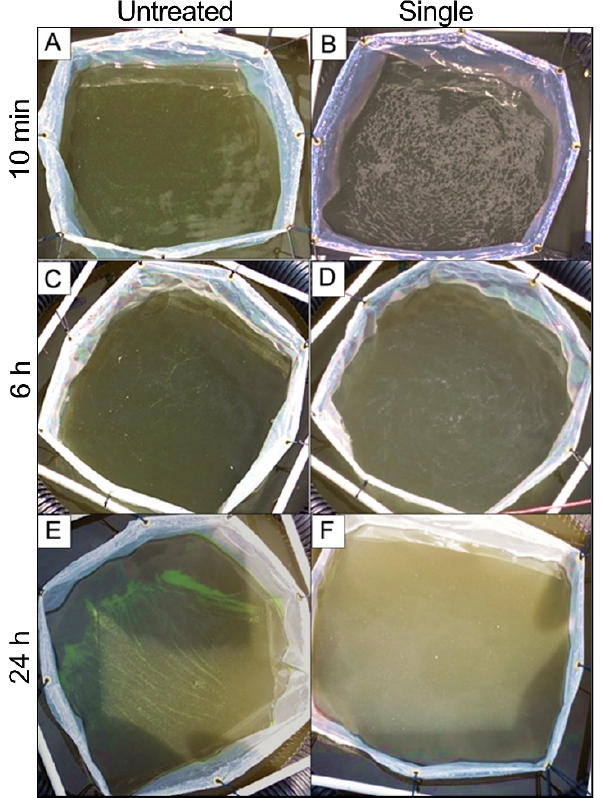
Figure 4. Representative images of in situ mesocosms at Pahokee Marina, Lake Okeechobee, FL. Images display conditions 10 min ( A , B ), 6 h ( C , D ) and 24 h ( E , F ) post algaecide treatment for un- treated ( A , C , E ) and single application ( B , D , F )